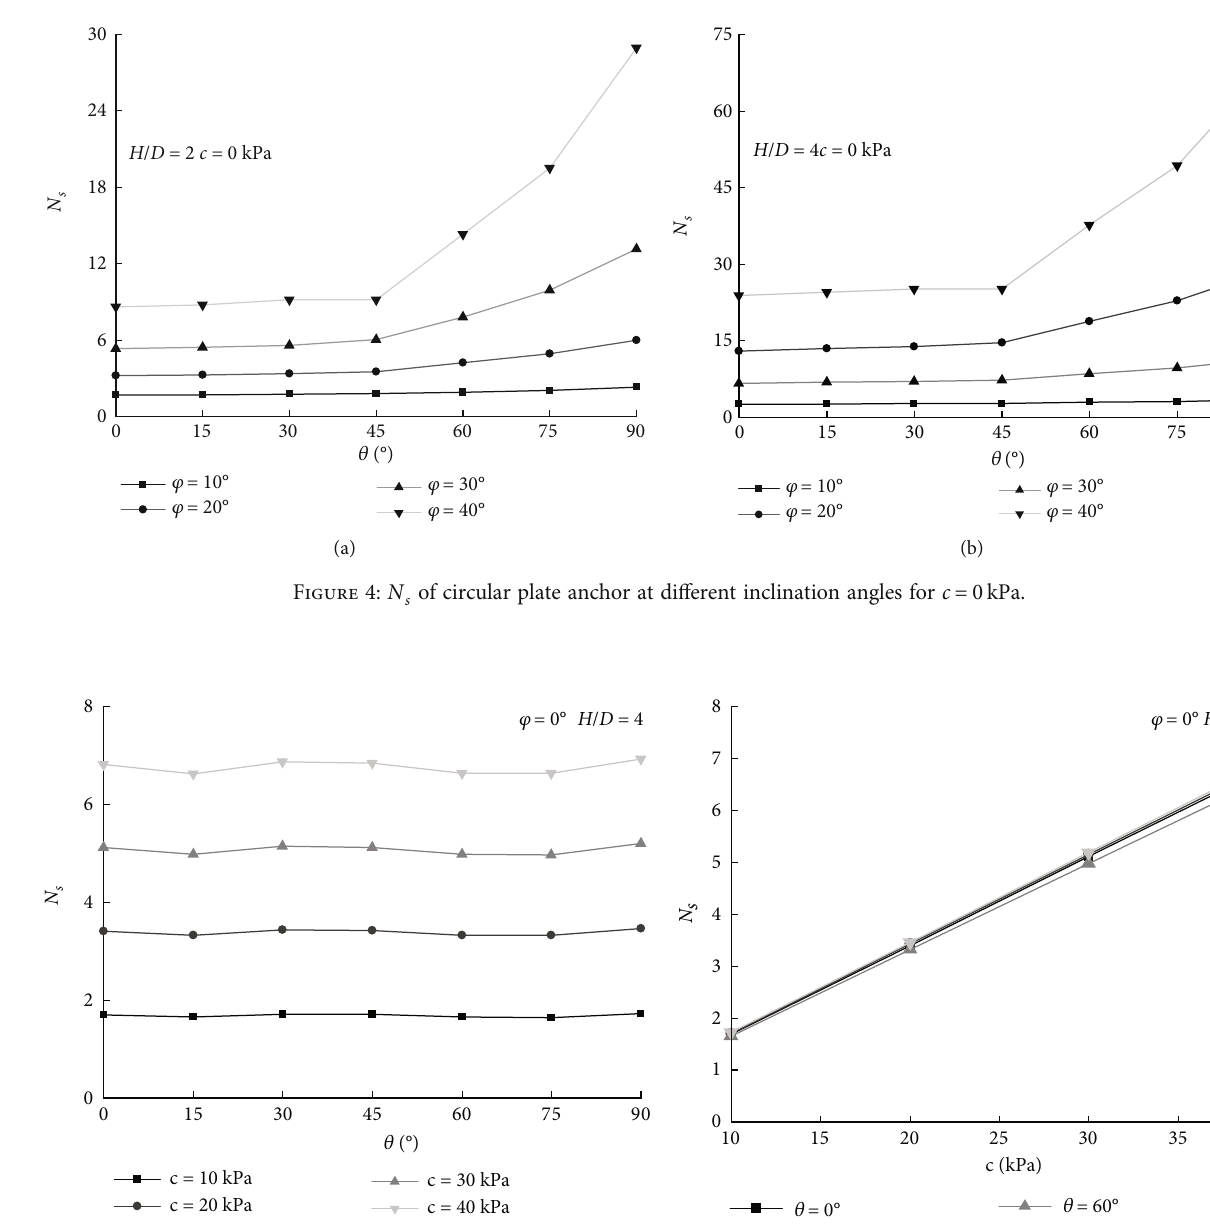
Figure 5: N s of circular plate anchor at di